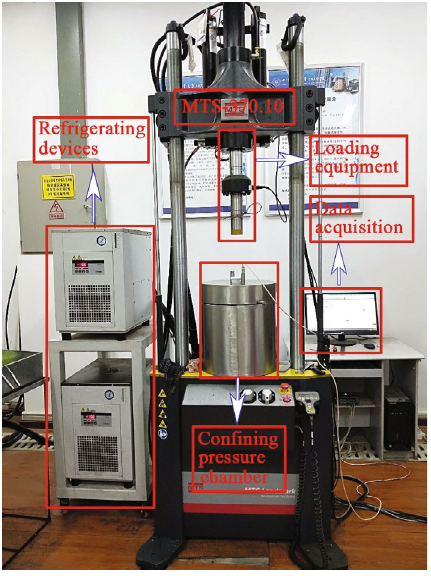
Figure 1: MTS-Landmark 370.10 triaxial testing instrument. Table 1: Basic physical parameters of natural silty